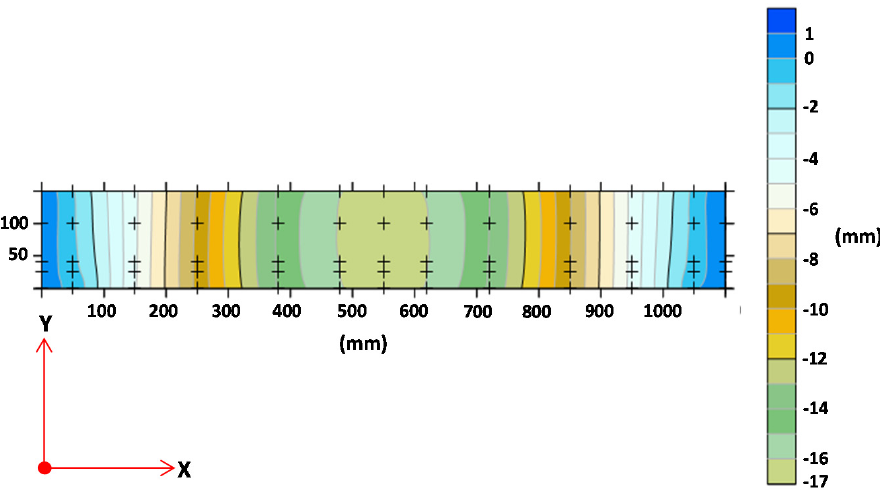
Figure14. Therelationshipofloadvs. displacementofBRCbeamoffiniteelementmethod(FEM)results. Figure 14. The relationship of load vs. displacement of BRC beam of finite element method (FEM) results.